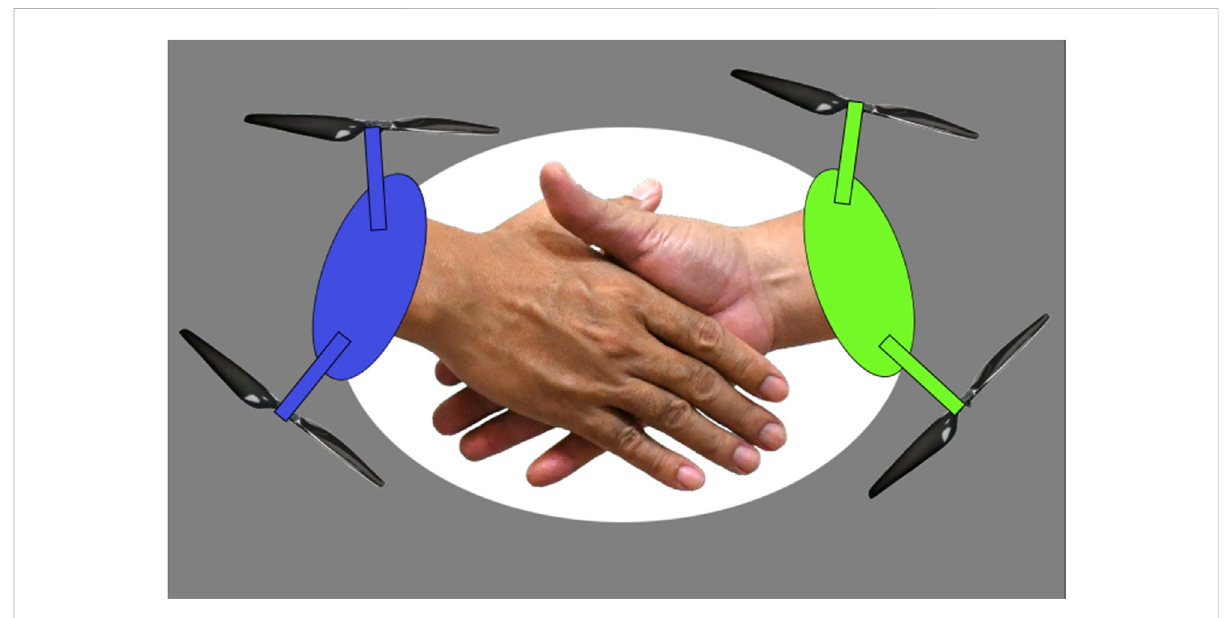
FIGURE 1 Drones cooperate to lighten the burden of the assigned task, just like when humans work together to achieve a common